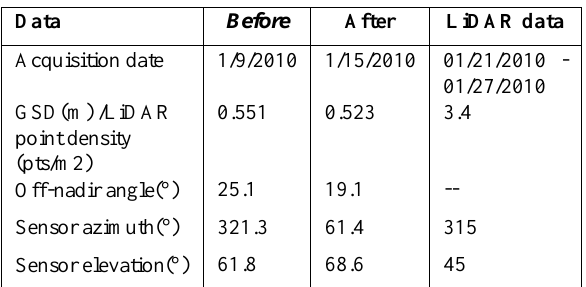
Table 1:Metadata of the data used Data Before After LiDAR data